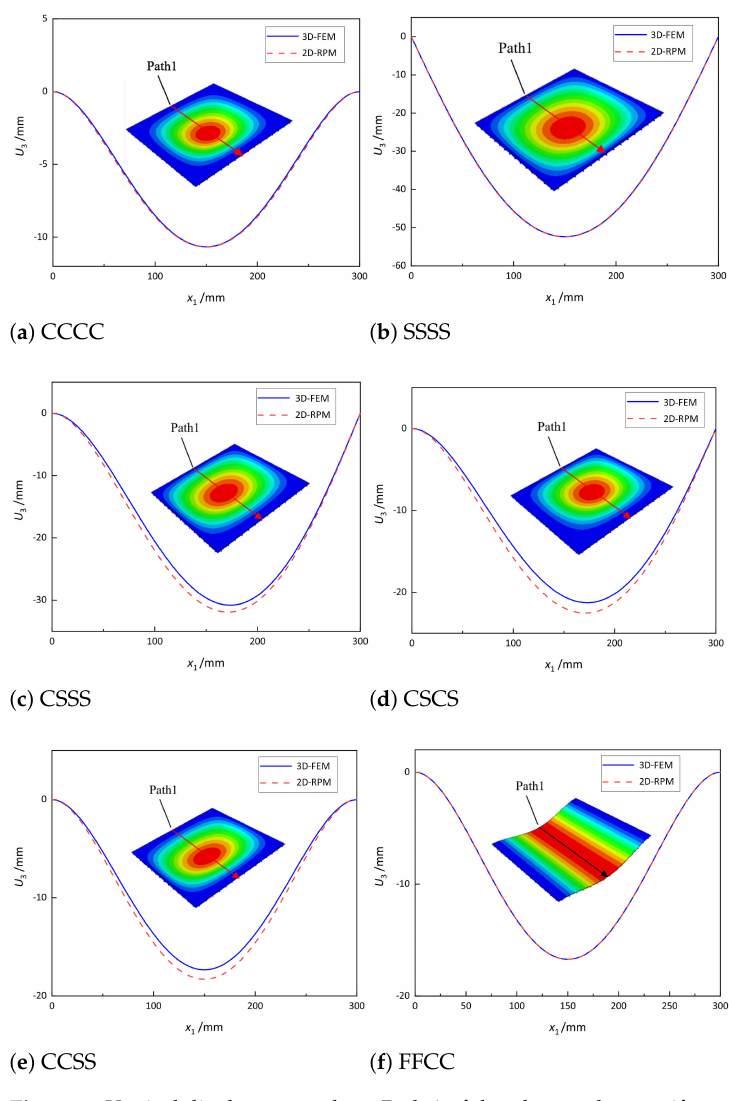
Figure 7. Vertical displacement along Path 1 of the plate under a uniform load of 5 kPa and different boundary